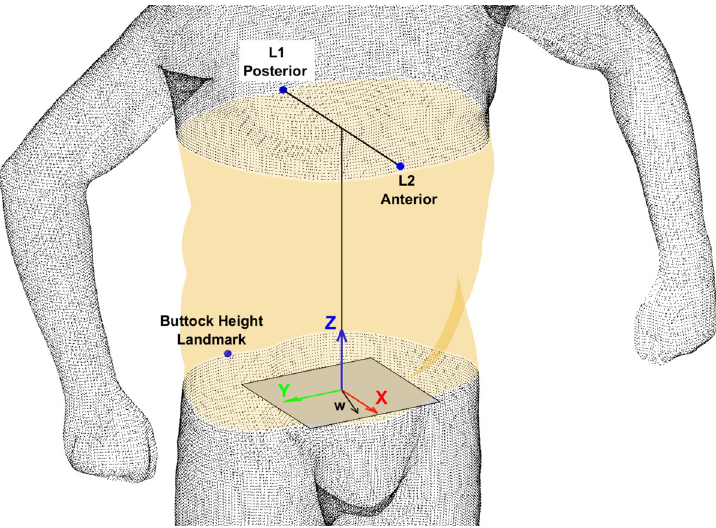
Fig 2. Landmarks used to segment the torso and create a local co-ordinate system within each 3D image. xiphoid process (Fig 1A). The local maxima and minima of the extracted data points along the x-axis were identified on the posterior and anterior aspects of the torso respectively (Fig 1B).